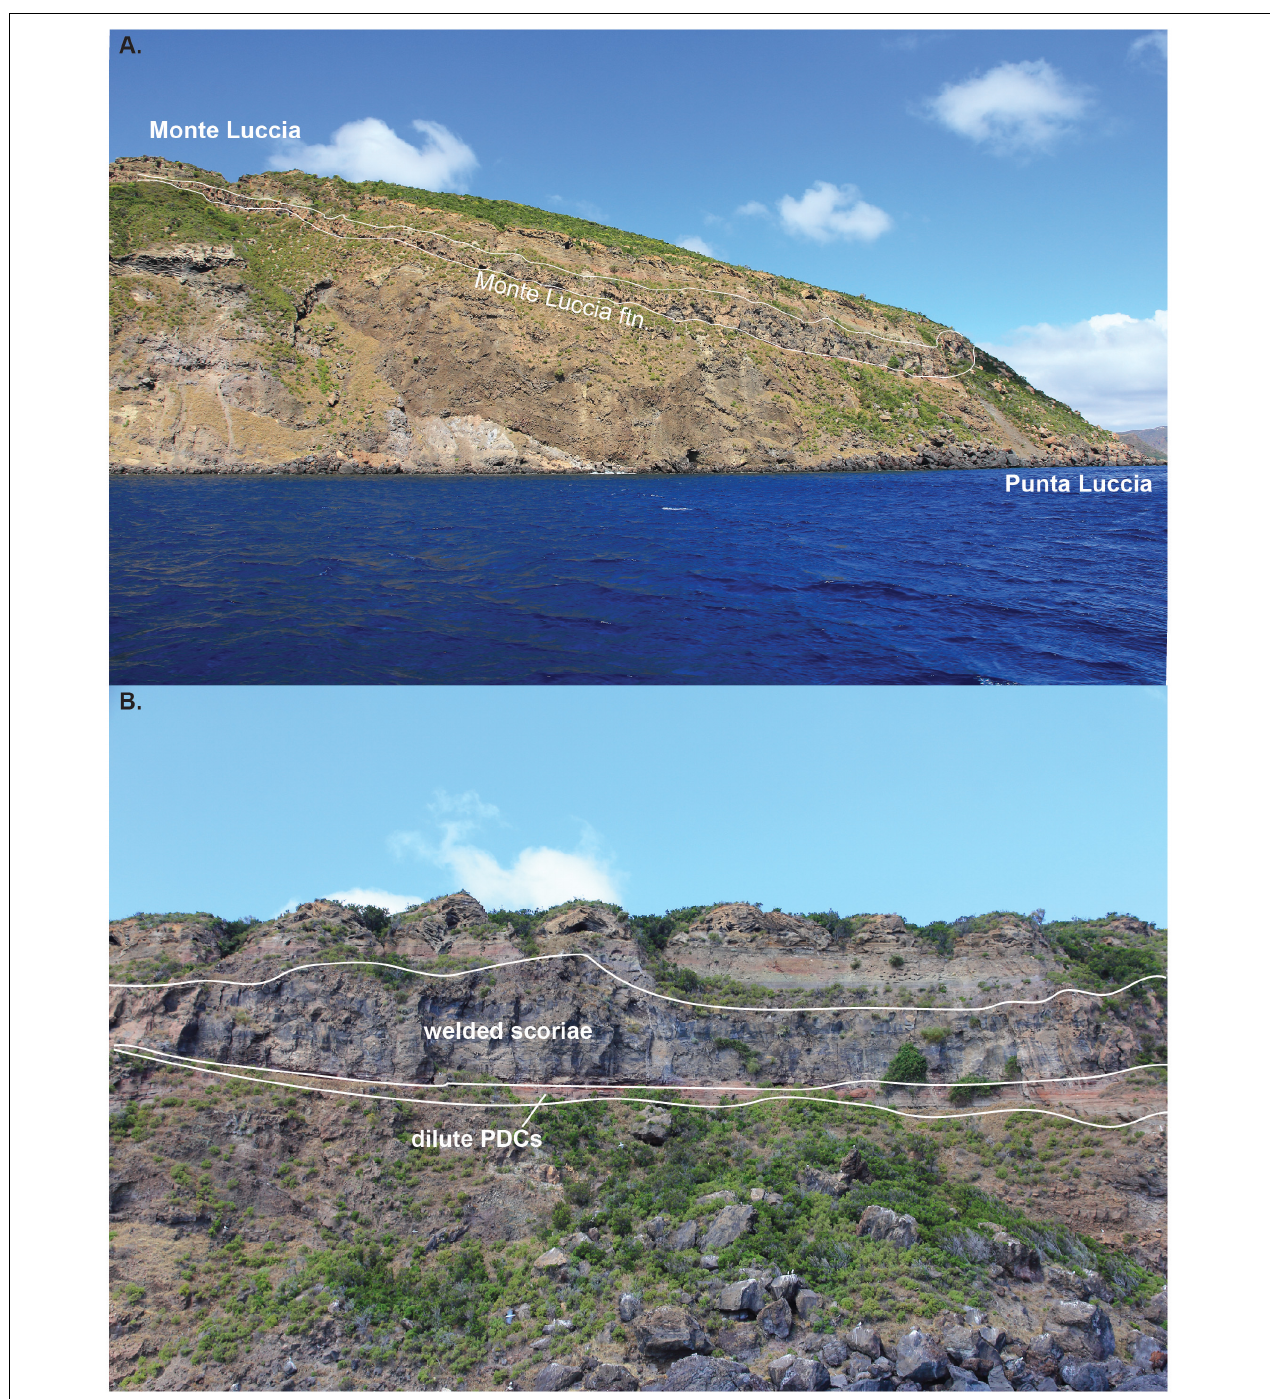
FIGURE 2 | Photos of Punta Luccia area, along the northern coasts of Vulcano island. (A) Panorama of the Monte Luccia formation; here the welded scoriae reach 25 m of thickness. (B) Detail photo of the Monte Luccia Formation, with indication of the dilute PDCs deposits at its base.